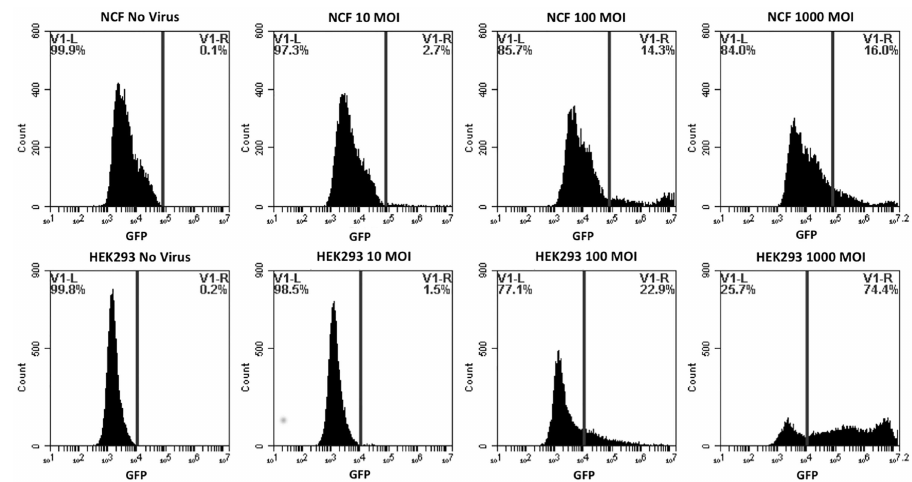
Fig 1. GFP Expression by non-cancerous normal canine fibroblasts (NCF) and HEK293cells. Cells were transduced by adenovirus Ad5G/L at three different multiplicityof infection (MOI 10, 100, and 1000 virus particles per cell). GFP expressionin cells was analyzedby flow cytometry 48 hours after Ad5G/L infection.